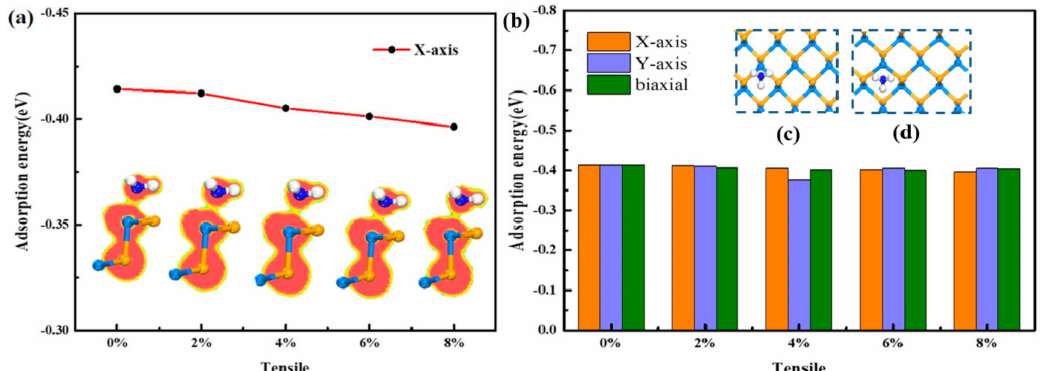
Figure 7. ( a ) The change curves of E ad with tensile strain from 0% to 8% in NH 3 / strained-SiSe systems, ELF from left to right represents 0%, 2%, 4%, 6%, and 8% of stress. ( b ) The comparison of adsorption energy with the X-axis, Y-axis, and biaxial under compressive strain from 0% to 8% in NH 3 / strained-SiSe systems, the data is shown in Table S1. The inset is morphology of NH 3 system ( c ) without stress and ( d ) with 8% stress in biaxial